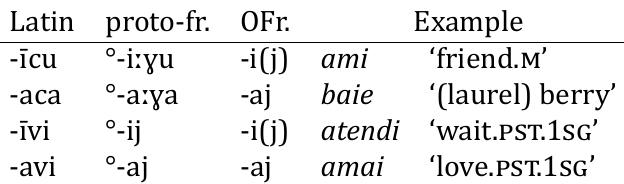
Table 5: Etymological comparison of Old French tonic [i]-(cid:976)inal forms with equivalents in tonic